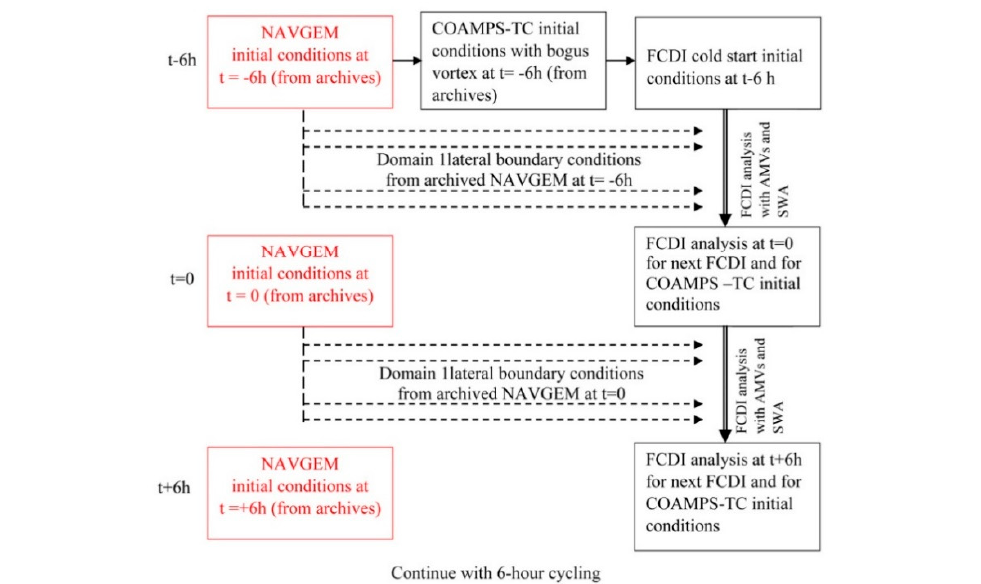
Figure 4. Flowchart as in Figure 3, except for the continuous six-hourly FCDI analyses as in this study in which the FCDI analysis within Domain 2 is not upscaled to NAVGEM. Rather, the archived NAVGEM fields each 6 h (red boxes) are used to provide the Domain 1 lateral boundary conditions for each FCDI analysis (dashed lines).